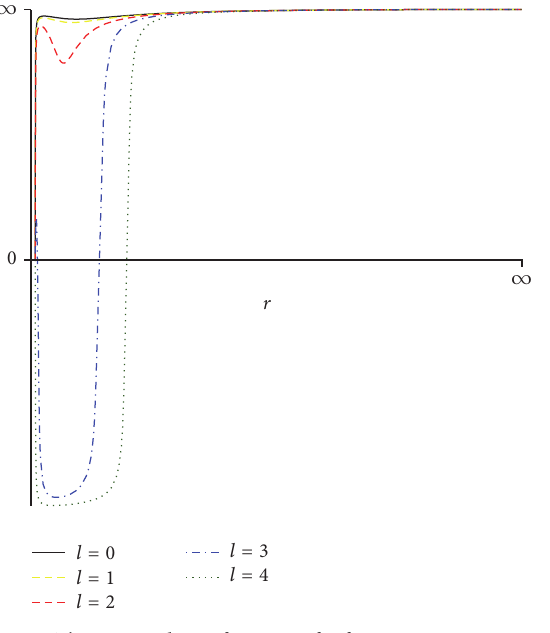
Figure 8: The potential 𝑉 in function of 𝑟 , from 𝑟 ℎ = 0.459413 to ∞ for 𝛼 0 = 0.677 , 𝑀 = 1 , and 𝜇 = 0.1𝑀 .